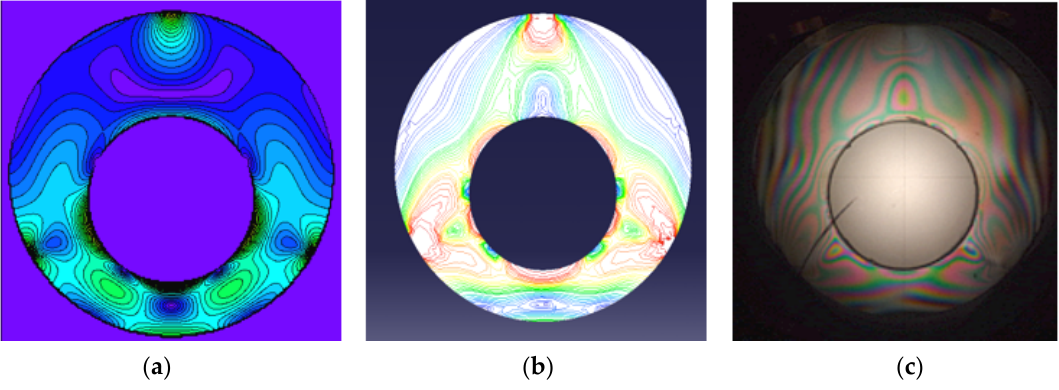
Figure 13. The eccentric ring loaded by three concentrated forces, Case d from Table 1. The theoretical isochromatic fields ( a ) differ substantially from the numerical ( b ) and experimental ( c ) results.